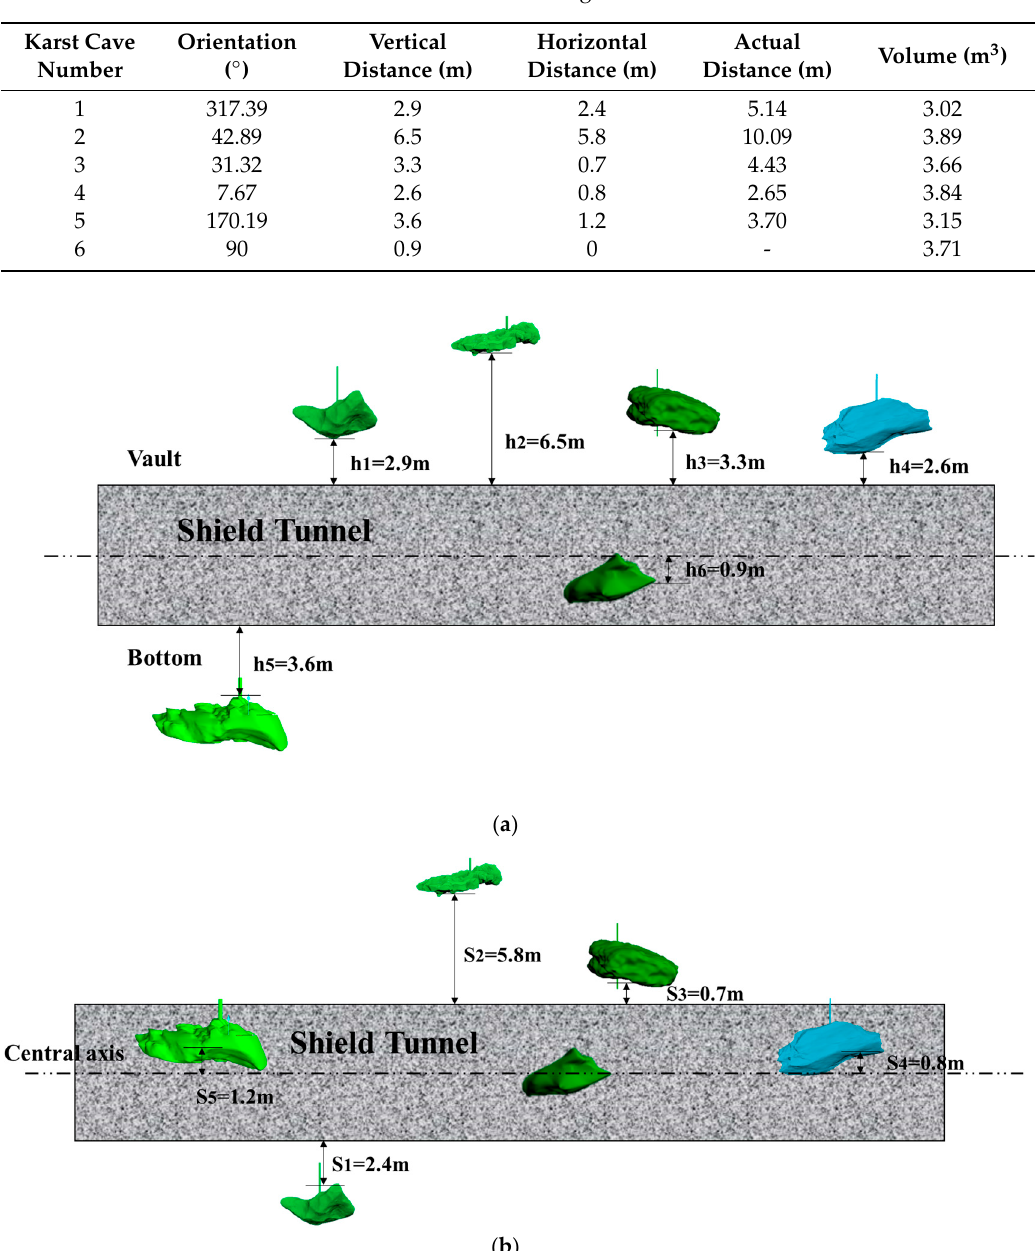
Figure 13. Relative positions between karst caves and the tunnel: ( a ) profile diagram; ( b ) plane graph.